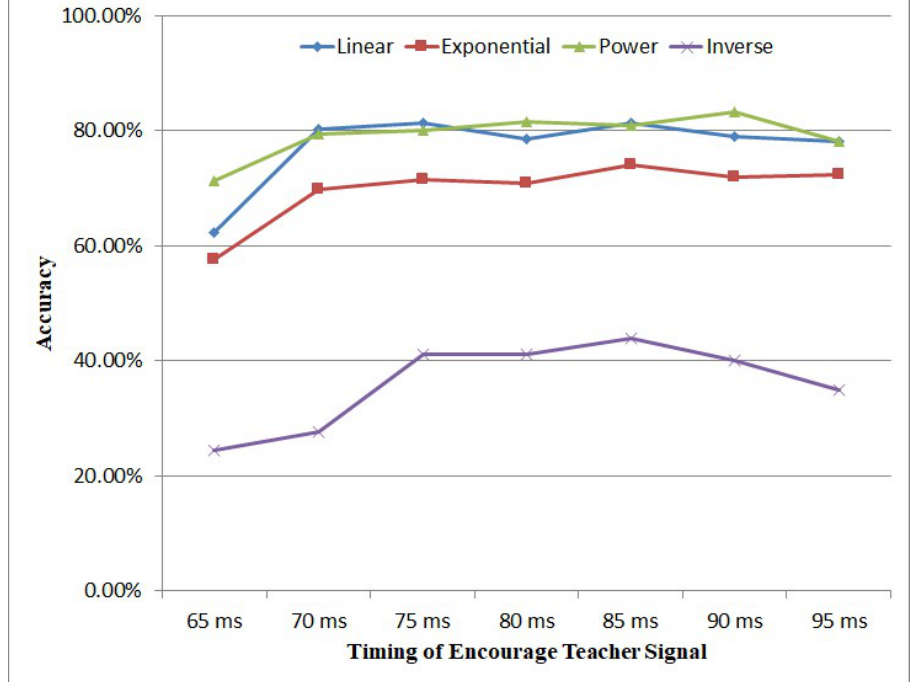
Figure 9. Influence of the timing of encouraging teacher